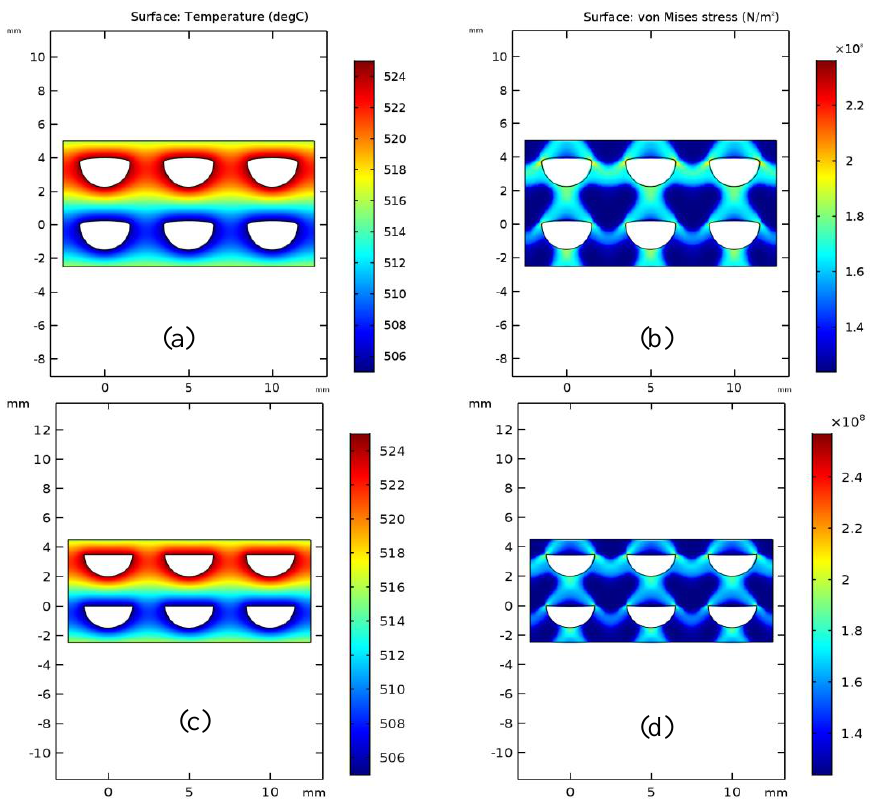
Figure 11. Pressure + thermal stress simulation result ( b , d ): temperature distribution ( a , c ). Energies 2020 , 13 , x FOR PEER REVIEW